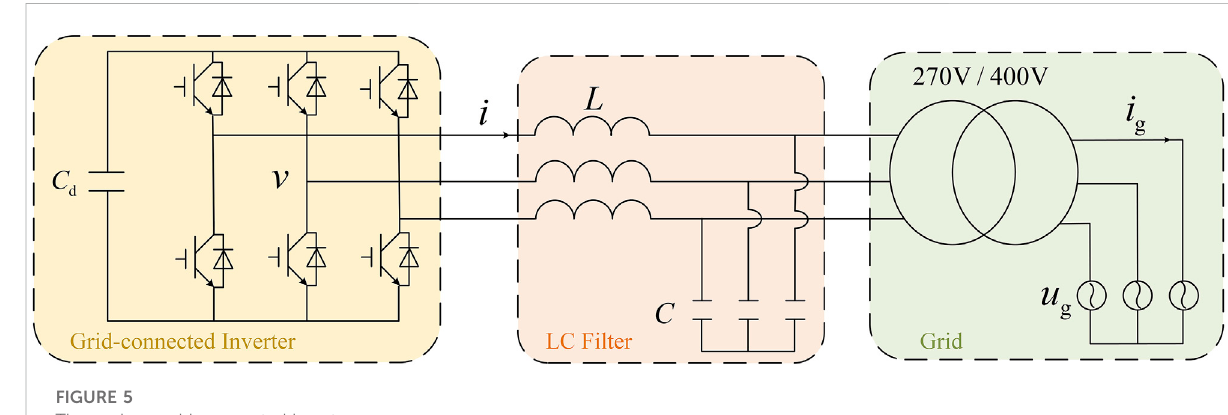
FIGURE 5 Three-phase grid-connected